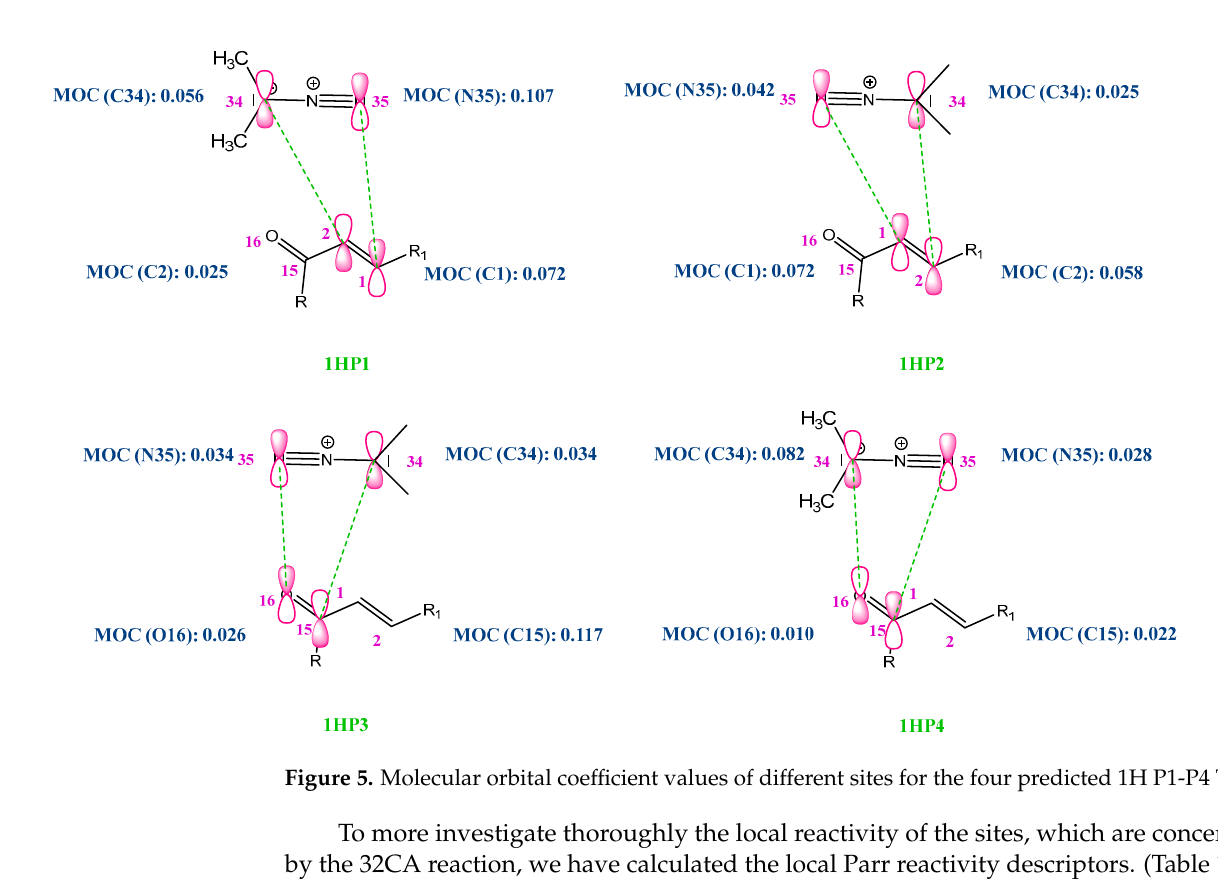
(cid:0) (cid:1) P + and electrophilic k